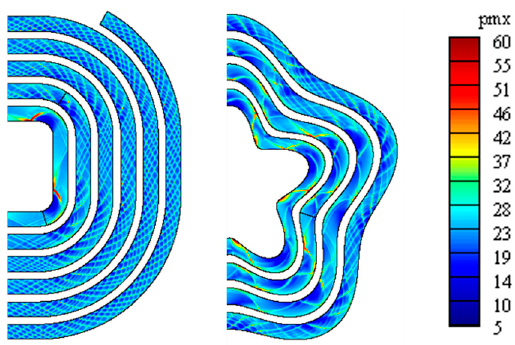
Figure 1. Numerical smoked-foil records of detonation wave propagation through various cross- sectional shapes, adapted from [1].